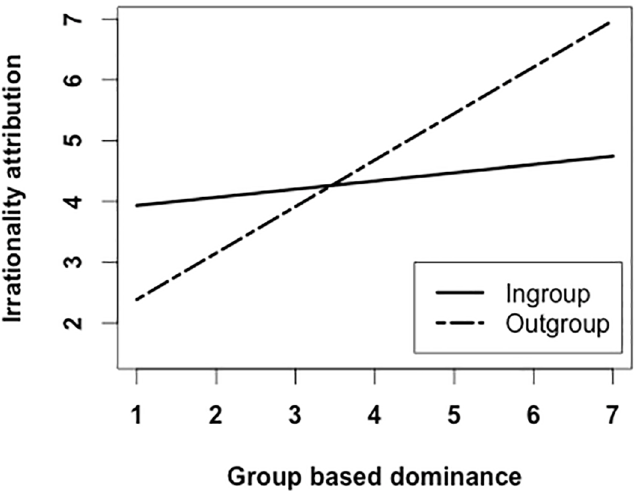
Figure 5. Plot of the two-way interaction effects for unstandardized variable group-based dominance and the target person’s membership on the perception of irrationality of the target